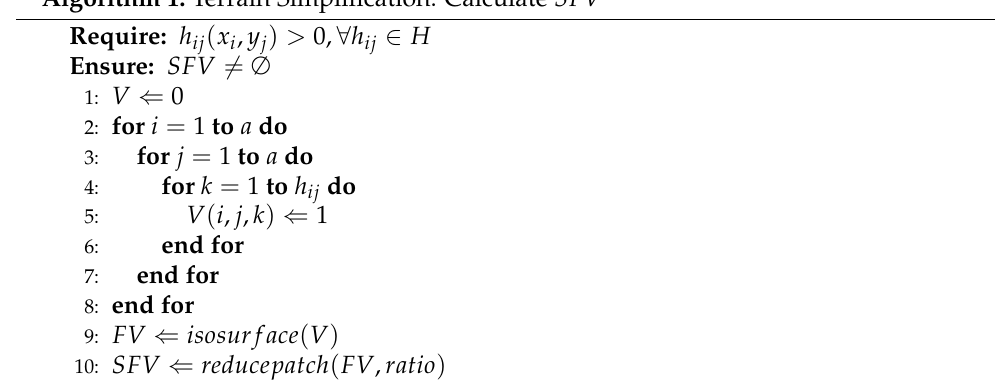
Algorithm 1: Terrain Simplification: Calculate